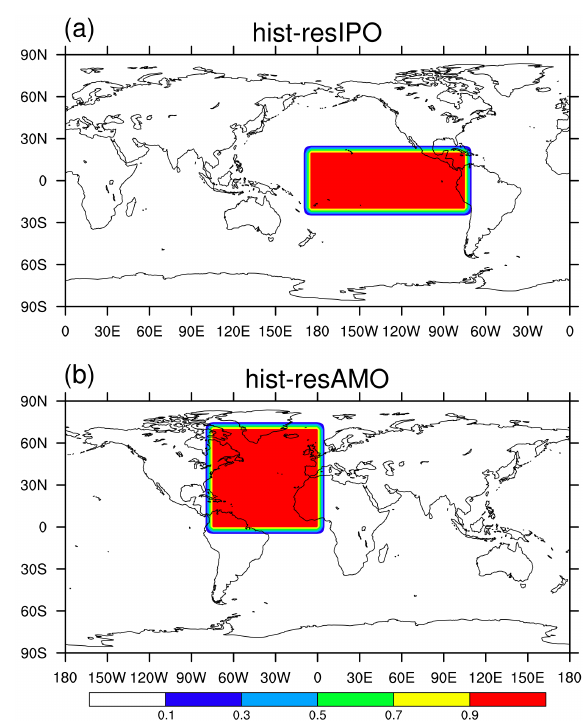
Figure 4. The restoring regions for tier-2 experiments (a) hist- resIPO and (b)